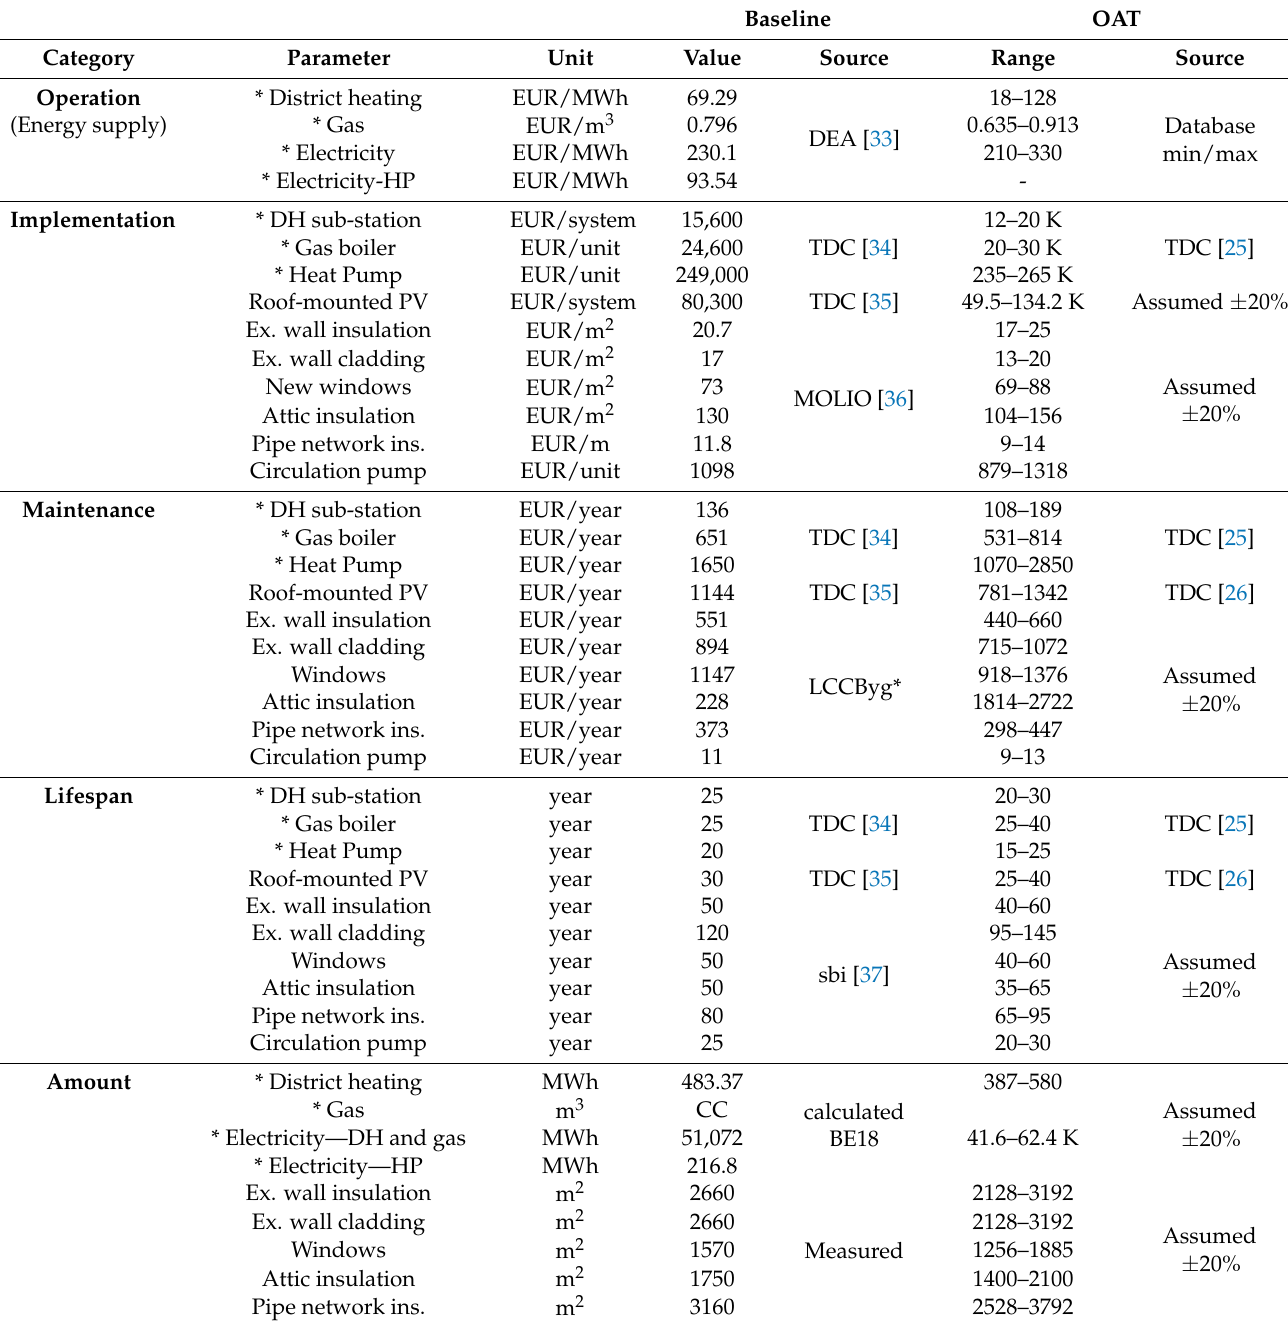
Table 1. List of input